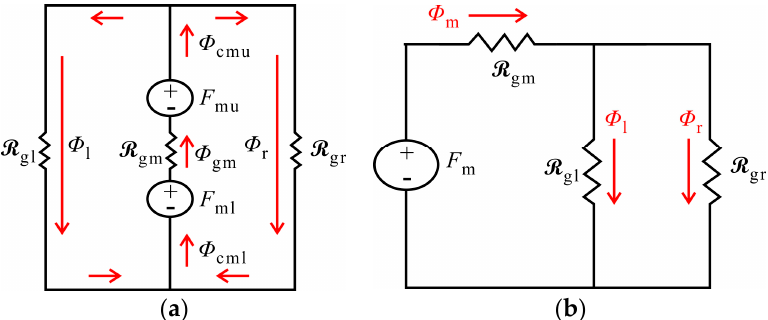
Figure 4. The reluctance of core material is neglected and redrawn the equivalent magnetic circuit: ( a ) equivalent magnetic circuit avoiding reluctance of the core material; ( b ) approximate equivalent magnetic circuit of the basic model.